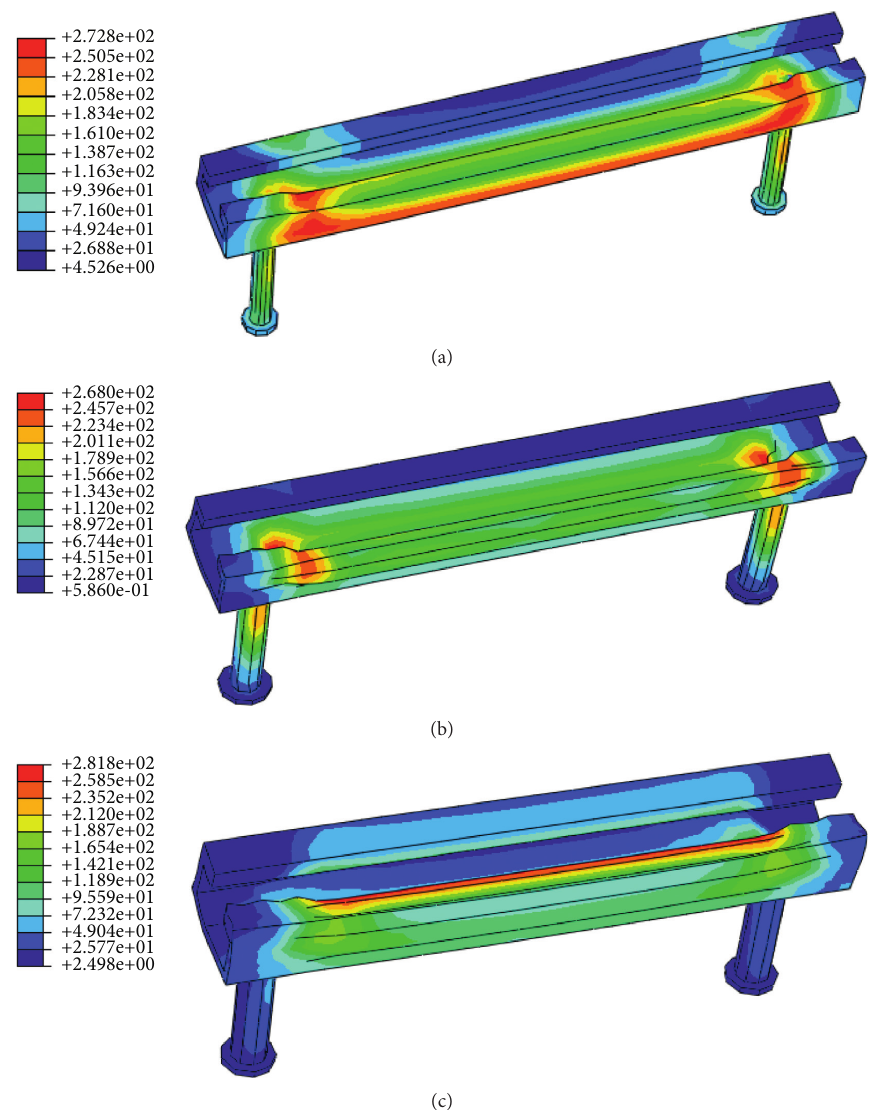
Figure 10: The embedded stress diagram for (a) B-1, (b) B-2, and (c) B-3 (unit: